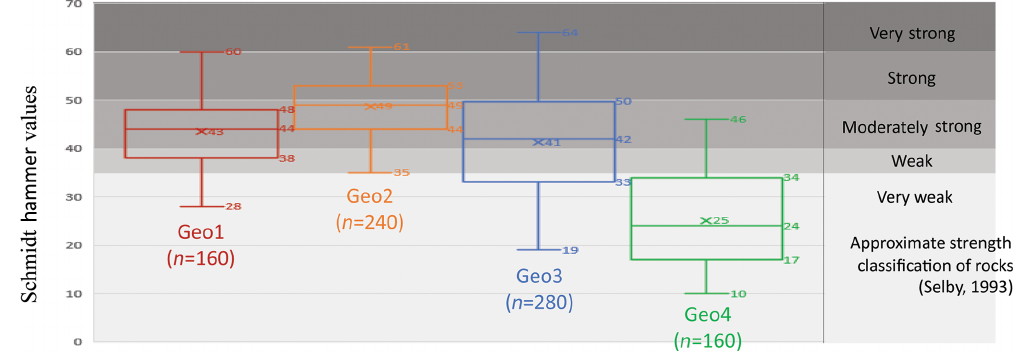
Figure 10. Box-and-whisker plots of Schmidt hammer values for geological groups of the studied zone where n represent the number of measurements. Graphic shows maximum, minimum and mean values for each geological group and also the values of the 75th, 50th and 25th percentiles for each group. Graphic shows the approximate strength classification of rocks by Schmidt hammer values after Selby